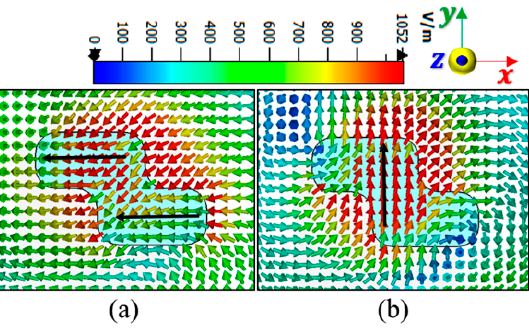
Figure 3. Effect of parameters (cid:1838) (cid:3046) on ( a ) S 11 and ( b ) AR and the effect of (cid:1875) (cid:3046) on ( c ) S 11 and ( d ) AR, for single-element DRA.